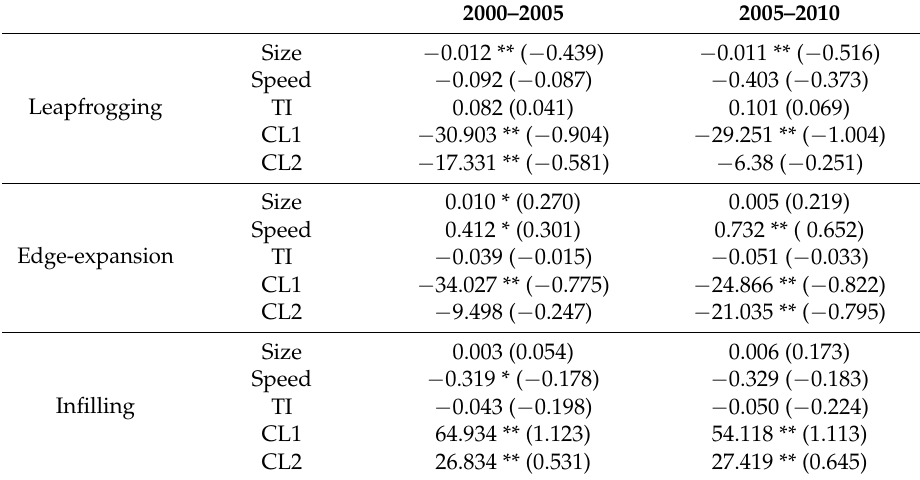
Table 6. Summary for the linear-regression